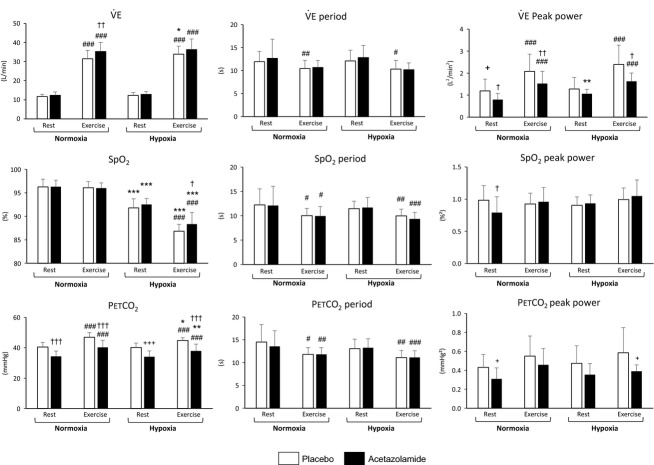
Mean (±SD) values of , SpO2, and PETCO2 and corresponding periods and peak powers in normoxia (Nx) and hypoxia (Hx), under placebo or acetazolamide treatment. Exercise versus Rest: #P < 0.05; ##P < 0.01; ###P < 0.001. Hypoxia versus normoxia: *P < 0.05; **P < 0.01; ***P < 0.001. Acetazolamide versus placebo: †P < 0.05, ††P < 0.01, †††P < 0.001.